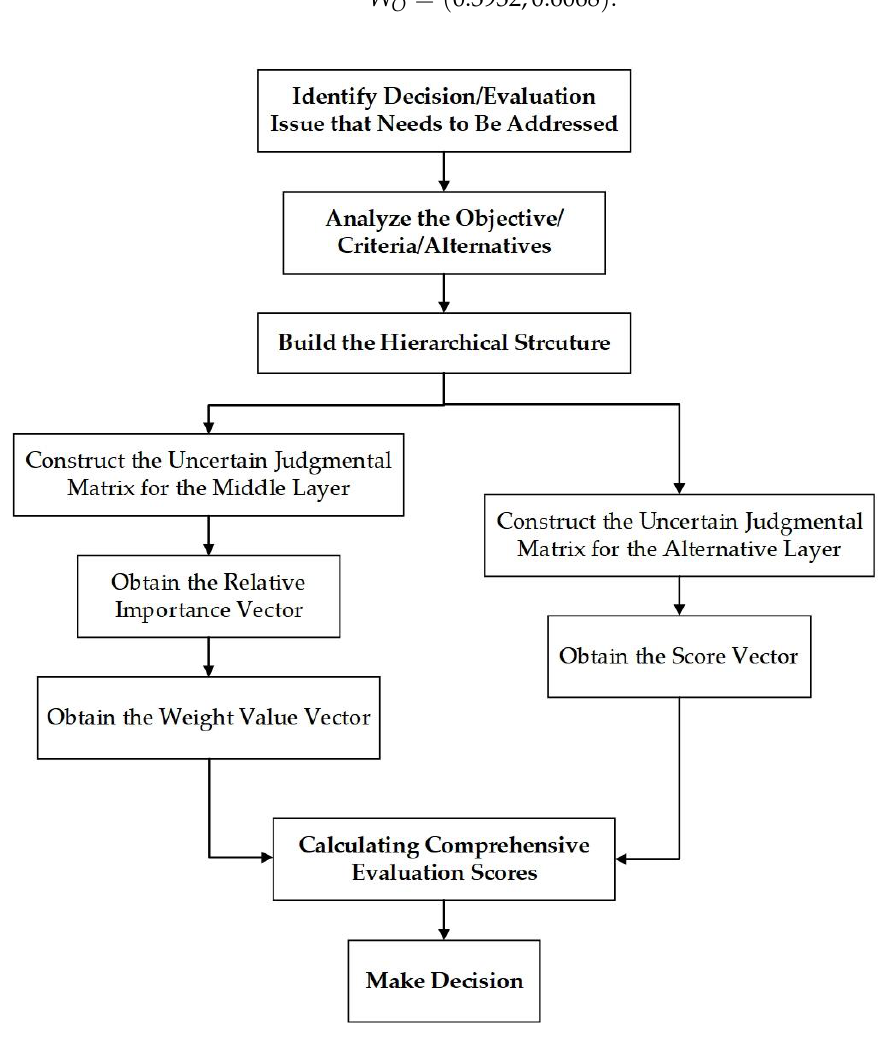
Figure 6. The overall evaluation procedure.